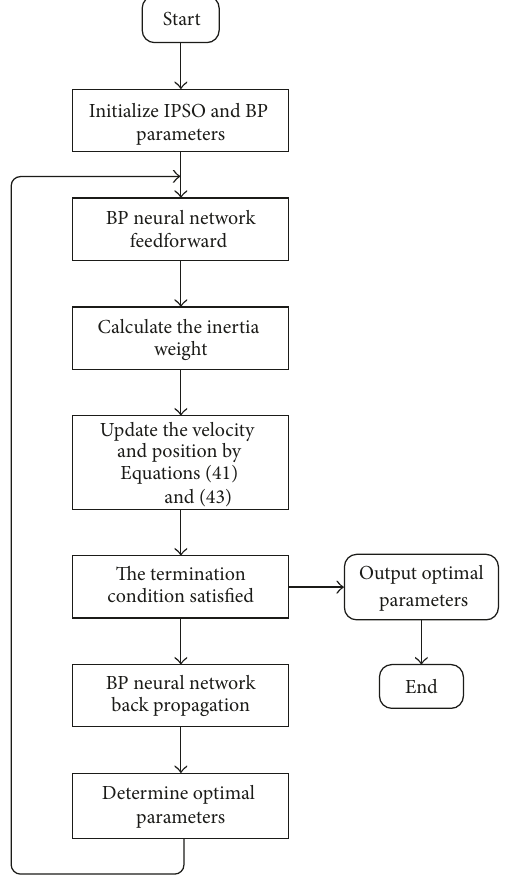
Figure7:FlowchartofusingIPSOalgorithmtooptimizetheweights of BPNN.